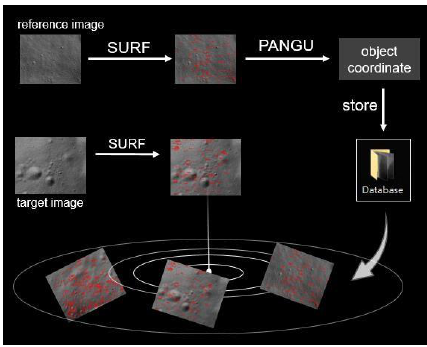
Figure 7. Illustration of visual-based absolute navigation